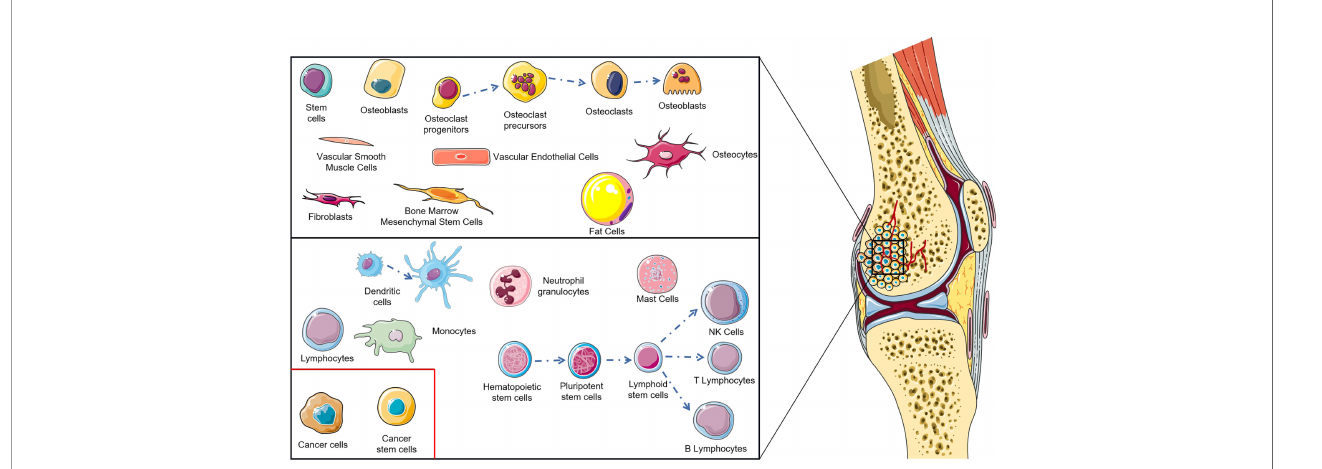
FIGURE 1 | Cellular composition of osteosarcoma tumor